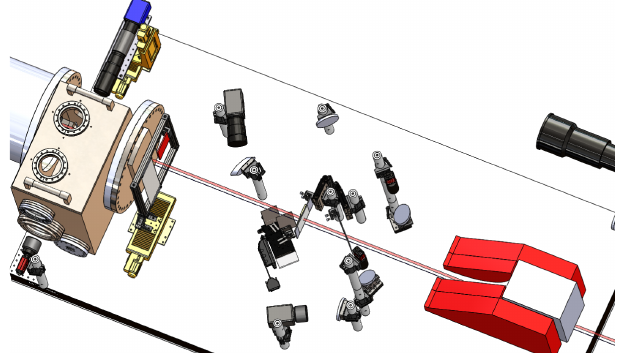
and the magnetic coils for the Compton spectrometer.